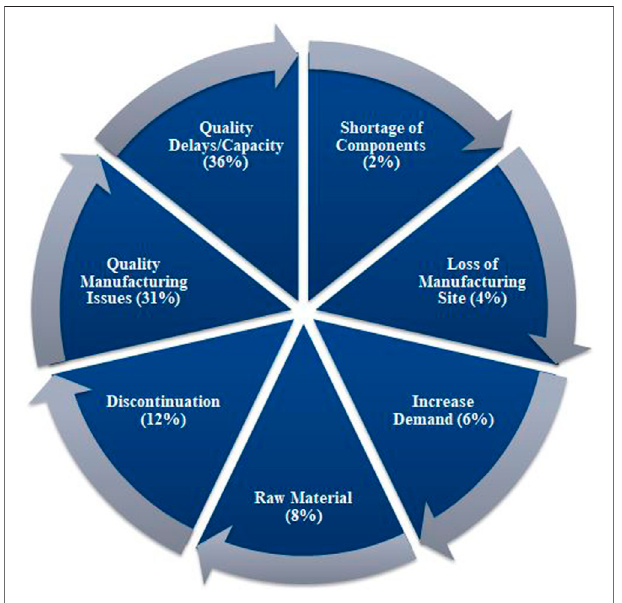
FIGURE 3 | Reasons of drugs in shortages in 2012 reported by University of Utah Drug Information Services (UUDIS) (Dill and Ahn, 2014). FIGURE 4 | Reasons of drugs in shortages in 2020 reported by University of Utah Drug Information Services (UUDIS) (Pharmacists, 2020).